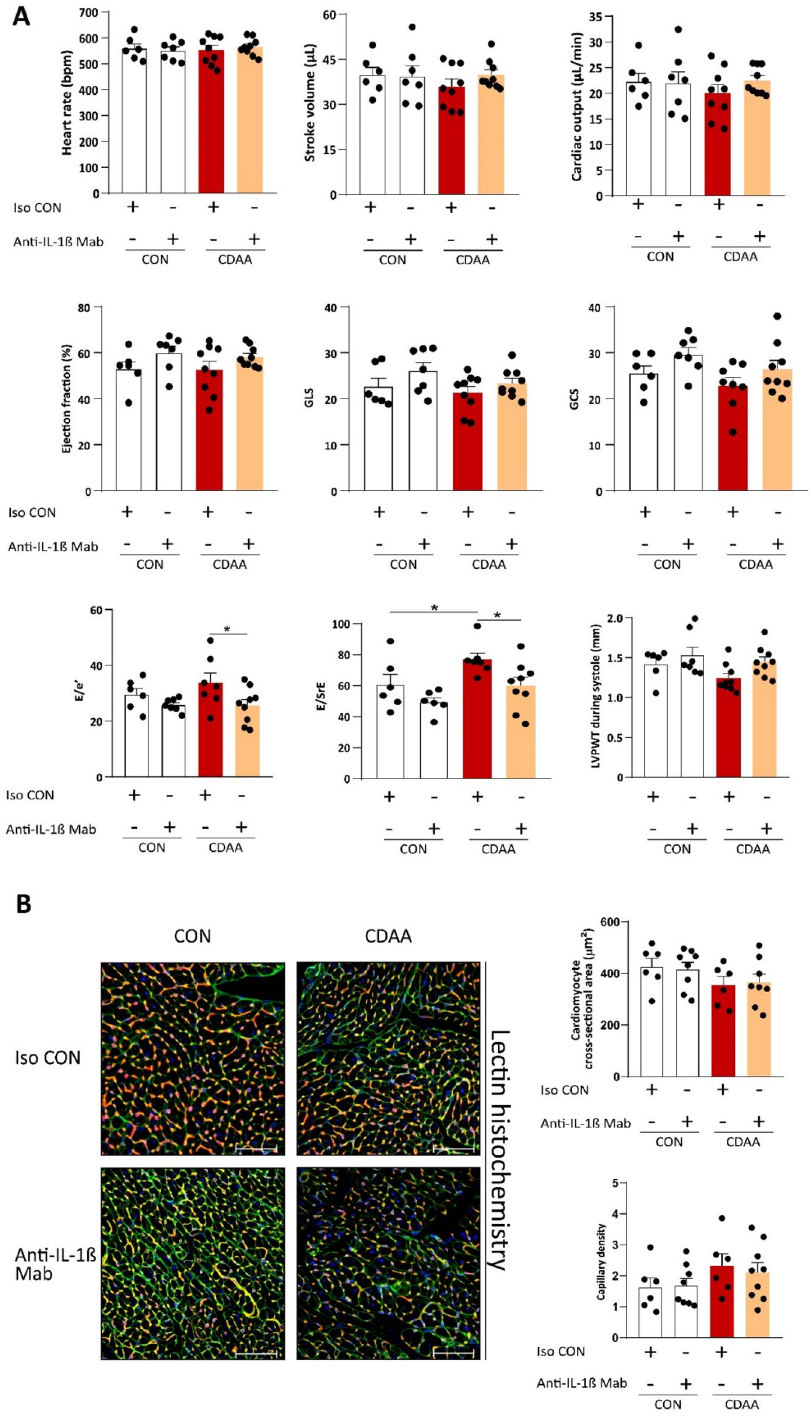
Figure 1. Cardiac function of mice in a CDAA diet-induced NASH model. Cardiac function assessment with conventional echocardiography and strain analysis with 2D speckle tracking ( A ) (n = 6–9/group). Cardiac lectin histochemistry. Green shows cardiac cell membrane, orange shows cardiac capillary endothelial cells, blue shows nuclei ( B ) (n = 6–9/group). CDAA, Choline Deficient L-Amino Acid-defined diet; CON, control diet; Iso CON, isotype control; Anti-IL-1β, anti-interleukin-1β monoclonal antibody; GLS, global longitudinal strain; GCS, global circumferential strain; SrE, early diastolic strain rate; LVPWT, left ventricular posterior wall thickness. Two-way ANOVA, Fisher’s LSD post hoc test, * P < 0.05, ** P < 0.01, *** P <